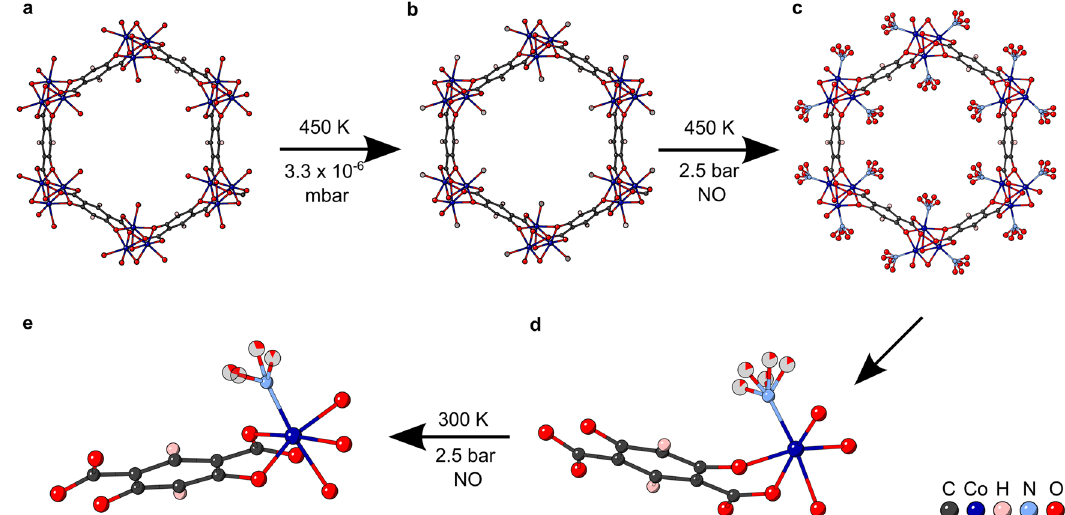
Fig. 4 Depiction of the crystal structure of Co-4,6-dhip, under different gas loading conditions, along the crystallographic c -axis with 40% space fi lling spheres and as asymmetric units with 50% probability ellipsoids. a Hydrated structure at room temperature and ambient pressure. b activated structure at 450 K and 3.3 × 10 − 6 mbar, with 7.7(4)% water occupancy, CCDC number: 2208831. c NO loaded structure at 450 K and 2.5 bar NO pressure, with 84.5(15)% NO loading, CCDC number: 2208834. The asymmetric unit space fi lling spheres set at the 40% level is shown in: d NO loaded structure at 450 K and 2.5 bar NO pressure, with 84.5(15)% NO loading. e NO loaded structure at 300 K and 2.5 bar NO pressure, with 92(3)% NO loading, CCDC number: